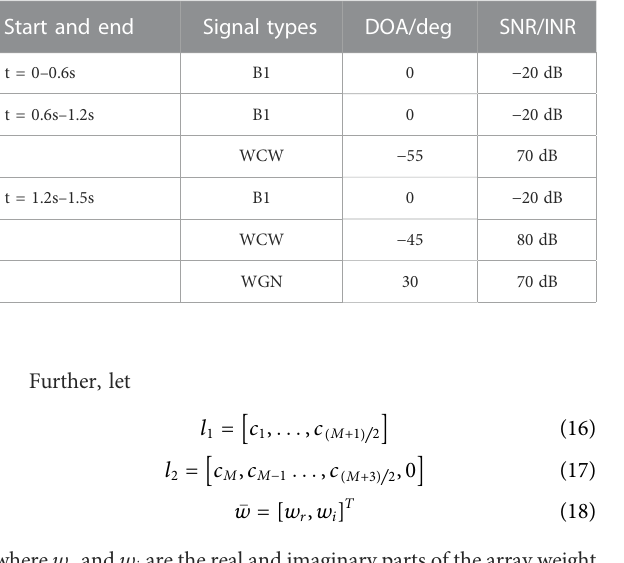
TABLE 2 Basic signal parameters.